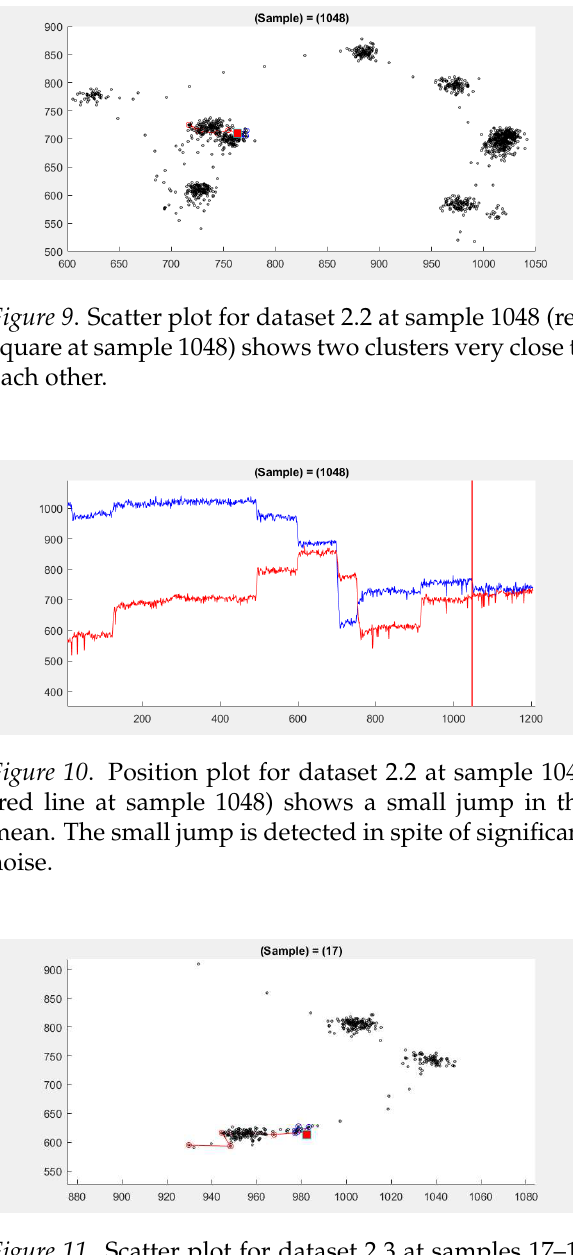
Figure 11 . Scatter plot for dataset 2.3 at samples 17–19 (red square at sample 18) shows two clusters.